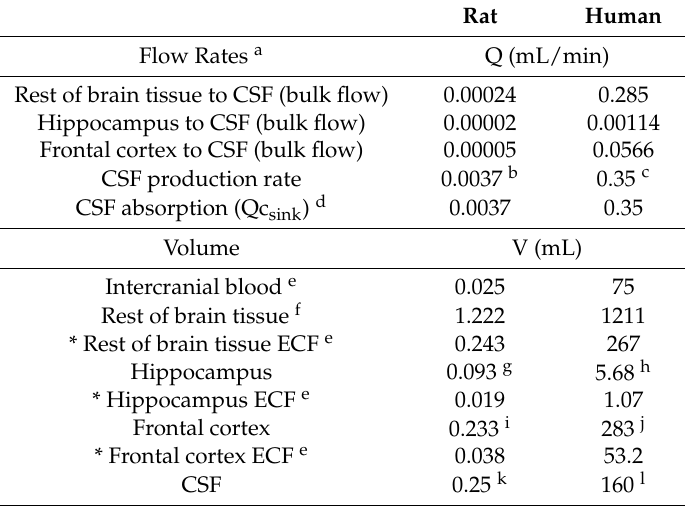
Table 2. System-related parameters used for the brain PBPK